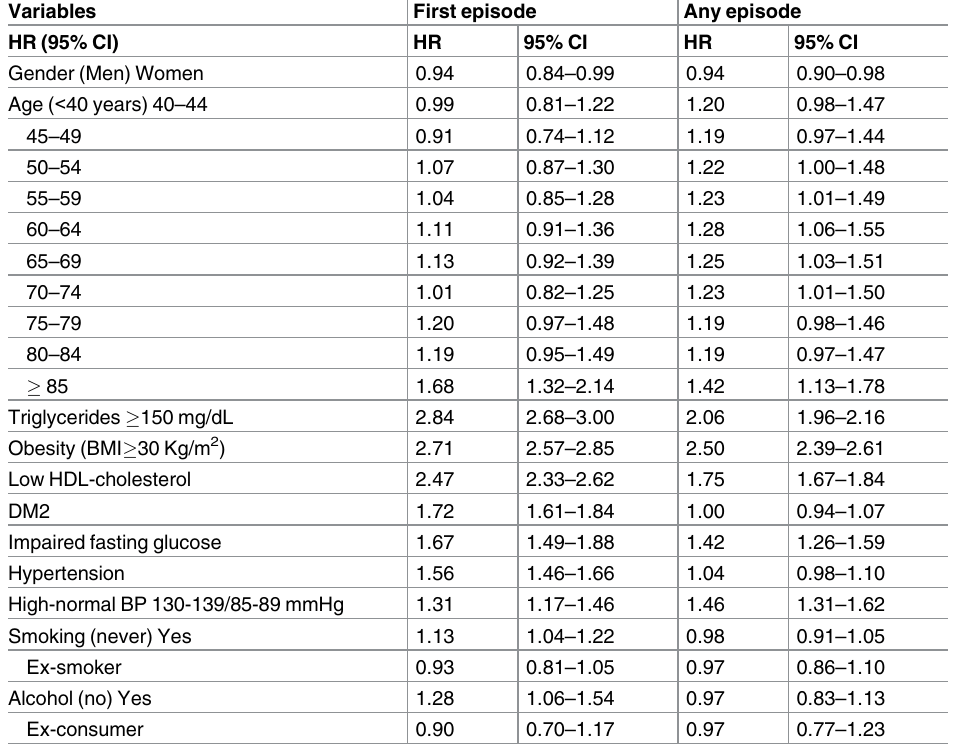
Table 4. Variables related to the risk of the occurrence of the first episode of metabolic syndrome and to the risk of the occurrence of any episode of metabolic syndrome. Multivariate analyses.